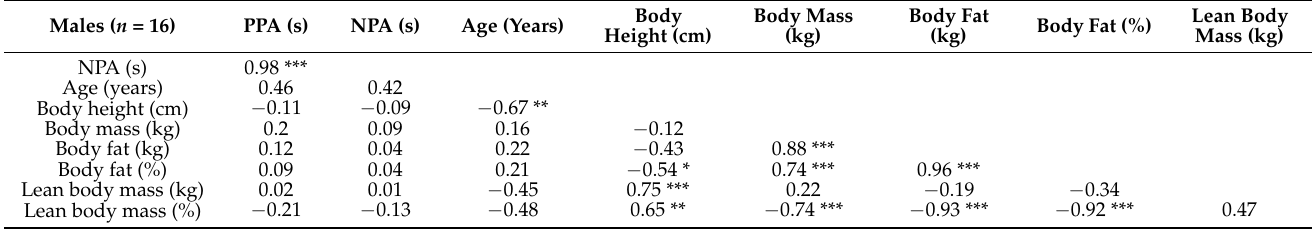
Table 6. Pearson’s correlation coefficients between studied variables for male